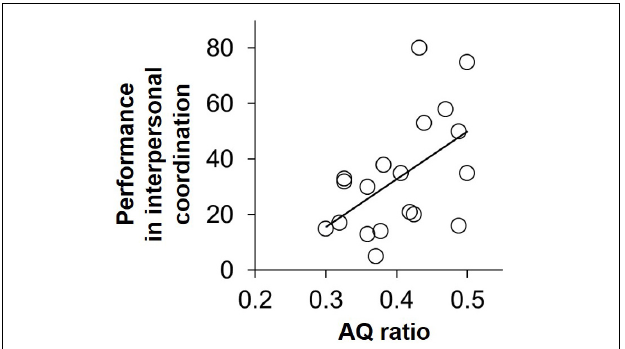
FIGURE 2 | The scatter plot between AQ ratio and performance value in IMC. The Pearson product-moment correlation of these two variables was significant ( r = 0.53, p =